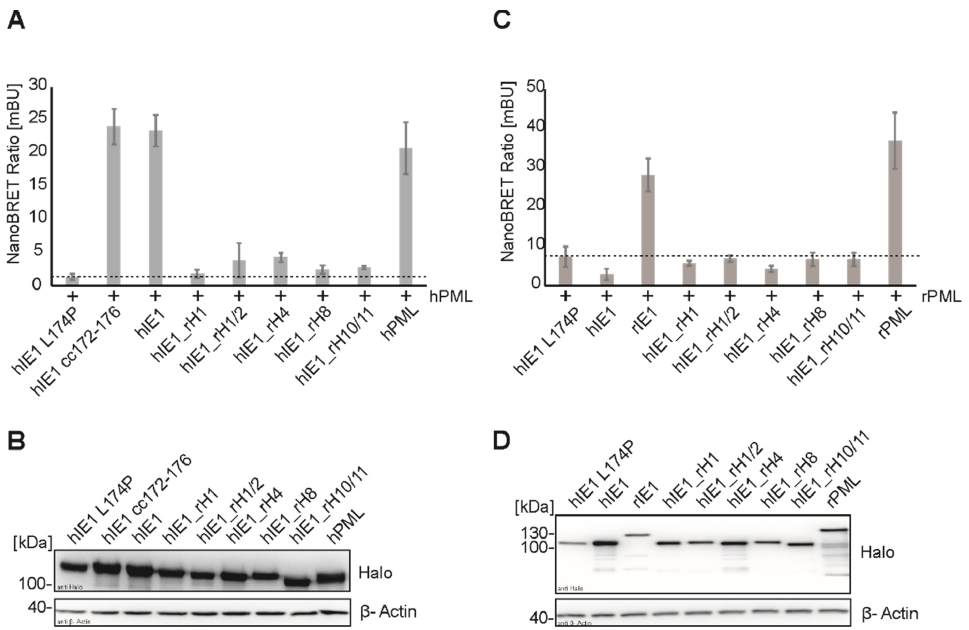
Figure 3. Cross-species interaction of IE1 homologs and IE1_rH mutants with PML by NanoBRET measurements. Interaction of IE1_rH mutants with human PML ( A ) and rat PML ( C ) was done by transfection of HEK293T cells with Halo tagged IE1 versions, and Luc tagged PML for 24 h. After 4 h of incubation with the Halo ligand, the measurement was performed with a detection time of 5 sec at wavelengths of 618 nm and 448 nm with the Hidex Chameleon. (A,B) Dotted lines indicate the NanoBRET ratio as obtained after coexpression of hIE1 L174P serving as a negative control. ( B , D ) The expression of the proteins in lysates of A and C was controlled by Western blotting. The proteins were stained with mAB Halo and mAB actin. Interactions of IE1 homologs with PML homologs are represented by the mean values ± SD from three independent experiments with three replicates each.